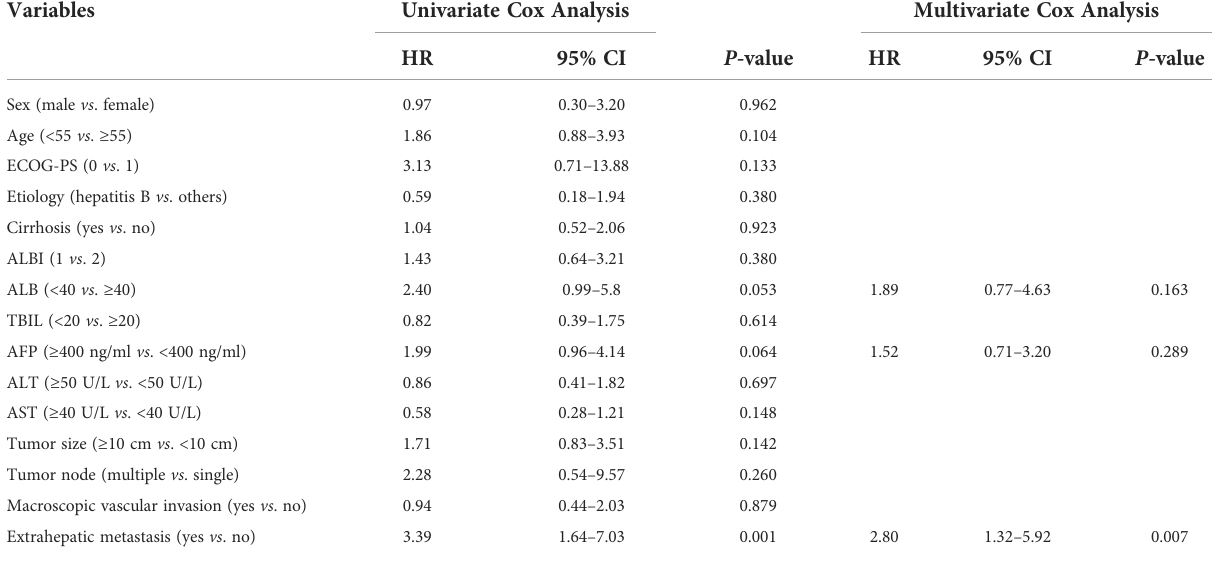
TABLE 4 Univariate and multivariate analyses of prognostic factors affecting PFS in advanced HCC.